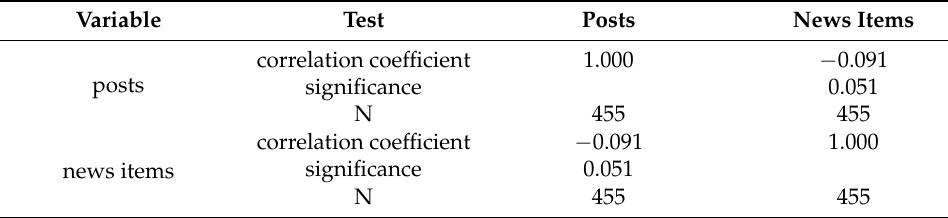
Table 5. Spearman’s rank correlation coefficient (posts and news items). Variable Test Posts News Items